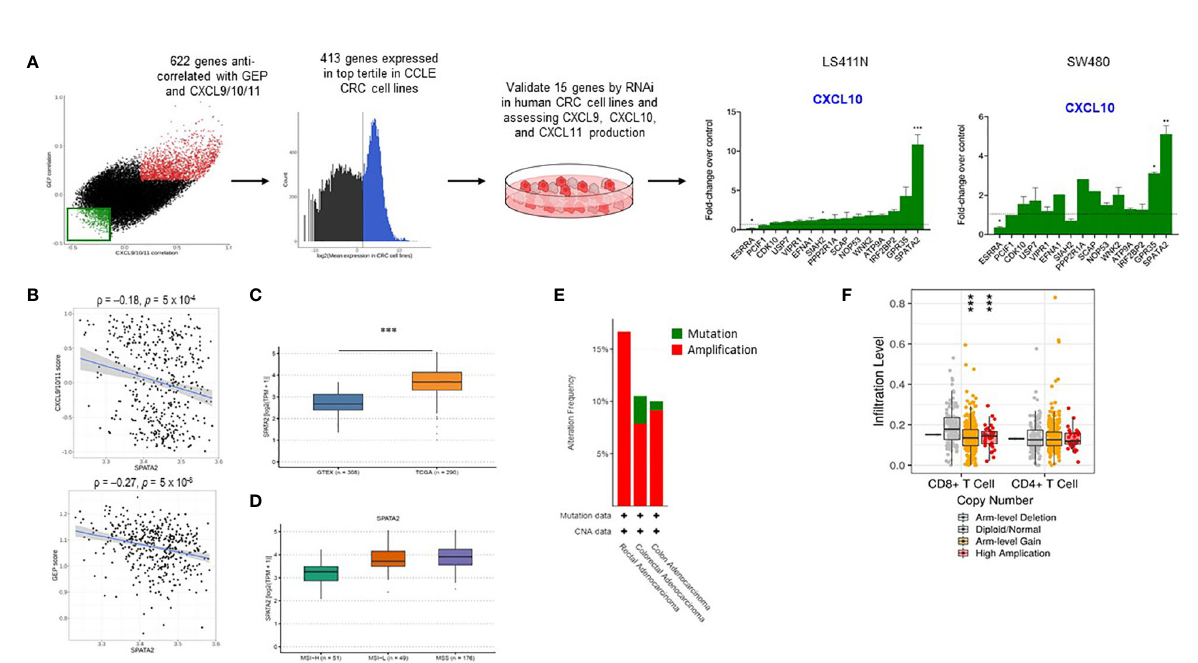
FIGURE 1 Identi fi cation of SPATA2 as a novel regulator of CXCL10 in colon cancer. (A) Overview of work fl ow for identifying potential novel regulators of CXCL9/10/11 and T-cell-in fl amed GEP. Gene expression data from TCGA CRC patients were used to identify genes that were anti-correlated with both CXCL10/11 and GEP (left panel). The aforementioned genes were fi ltered for high expression in CCLE CRC cell lines to enrich for tumor-intrinsic targets, and 15 candidates were selected for in vitro validation using RNAi and production of CXCL9, CXCL10, and CXCL11 as the readout (middle two panels). Fold-change of CXCL10 secretion elicited by knockdown of each indicated target relative to control-siRNA-treated cells for indicated cell lines are shown (right panel). Bars are ordered based on the fold-change values for CXCL10 in LS411N. Data are representative of 2-6 independent experiments. (B) Plots of CXCL9/10/11 (top) or T-cell-in fl amed GEP (bottom) scores versus SPATA2 expression in TCGA CRC samples. Spearman correlation coef fi cients ( r ) and p values adjusted for multiple testing by Benjamini-Hochberg method are indicated. (C) Transcript levels of SPATA2 in TCGA CRC tumors versus healthy colon in GTEx. (D) Transcript levels of SPATA2 in TCGA MSS CRC tumors versus MSI CRC tumors. (E) Frequency of the indicated genomic alterations in SPATA2 in TCGA CRC tumors. (F) Relative abundance of the indicated T cell populations in TCGA CRC tumors inferred using TIMER. Mean + SEM (B) ; Boxplots showing median and interquartile range (E) . * p<0.05, ** p<0.01, *** p<0.001 (B, C, E) ; One-sample Student ’ s t test (B) , Wilcoxon rank-sum test (C, D)